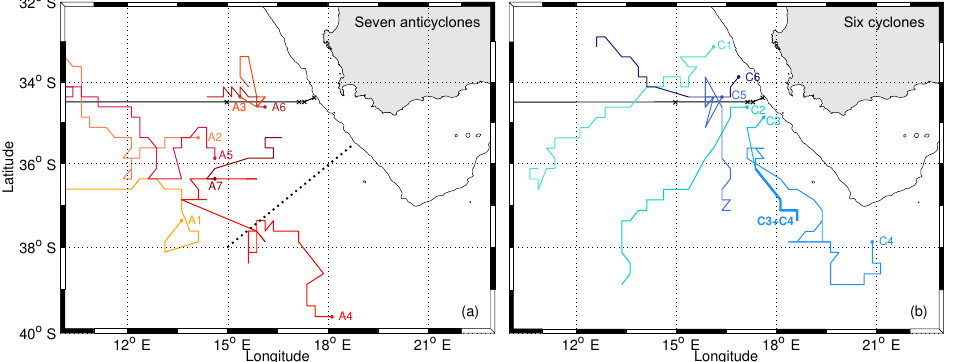
Figure 4. Eddy trajectories from 15 September 2014 to 15 December 2015 for eddies influencing the mooring measurements. The eddies are named A1–A7 (anticyclonic eddies – a ) and C1–C6 (cyclonic eddies – b ), with the numbers assigned in chronological order by the eddy-tracking scheme. The circles indicate the starting positions of an eddy track. The bold blue line in (b) represents the trajectory of an eddy after a merging. (a) The dashed black line represents the northern route of Agulhas rings defined by Dencause et al. (2010). Table 3. Characteristics of the eddies passing over the moorings from satellite altimetry. The time period, the radius, and the azimuthal velocity of the different eddies are derived from our eddy detection method. The eddies are named C1–C6 (cyclonic eddies) and A1–A7 (anticyclonic eddies), with the numbers assigned in chronological order by the eddy-tracking